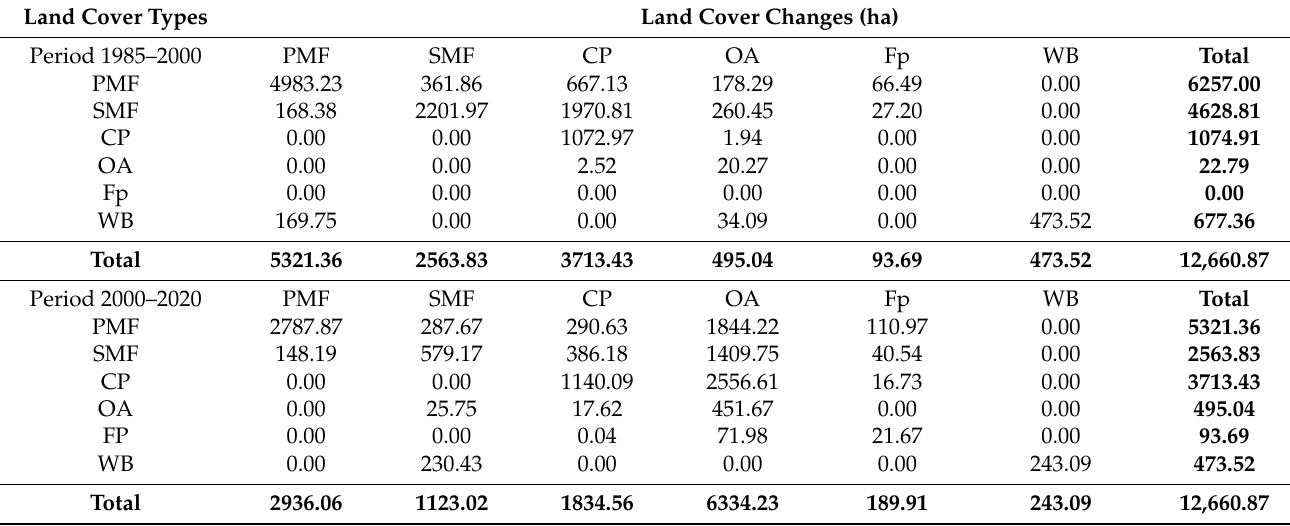
pond; WB—water body.